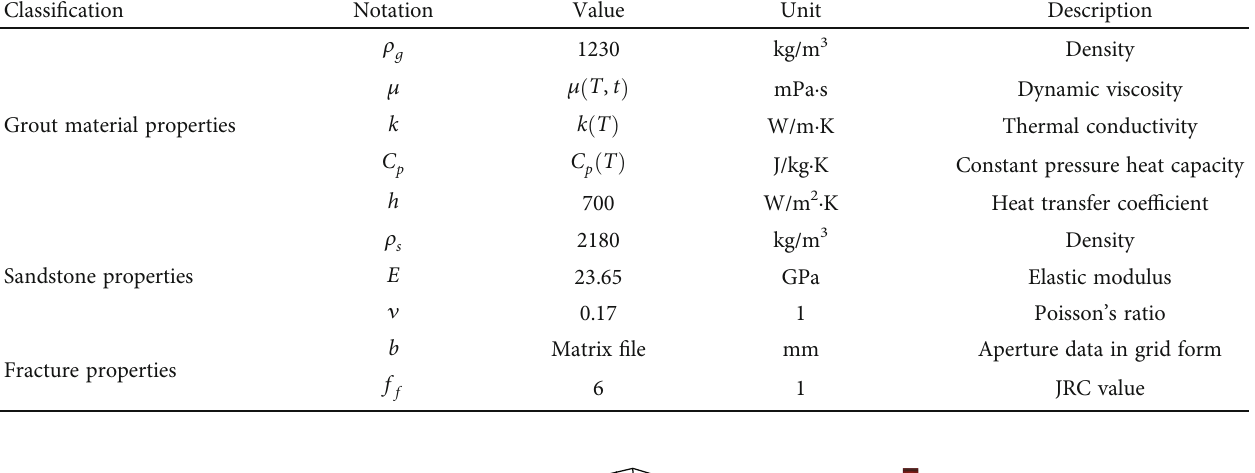
Table 1: Input parameters for the model.